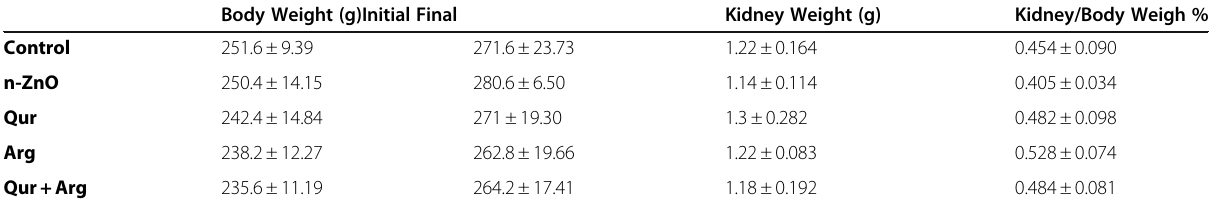
Table 5 Effect of Qur and/or Arg treatment on body weight, kidney weight, and kidney/body weight % in intoxicated rats with a low dose of n-ZnO particles